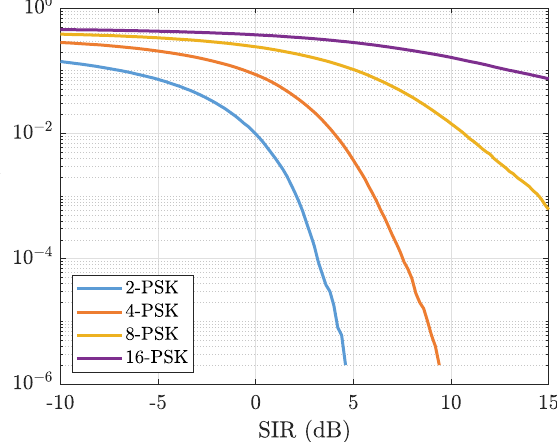
Figure 11. Alamouti 2 × 2 with the presence of the partial band noise (PBN) jammer. BER as a function of the SIR. Different modulation orders 2, 4, 8, 16–PSK and SNR = 15